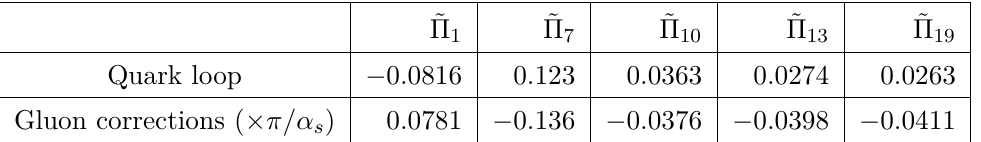
Table 2 . Values for the quark loop and gluonic correction contributions to the ˜Π in GeV units for a benchmark tuple ( Q 2 , Q 2 , Q 2 ) = (1 , 1 . 3 , 1 . 7) GeV 2 . Sum over the three flavours has been made. 1 2 3 The last line is in units of α s /π .